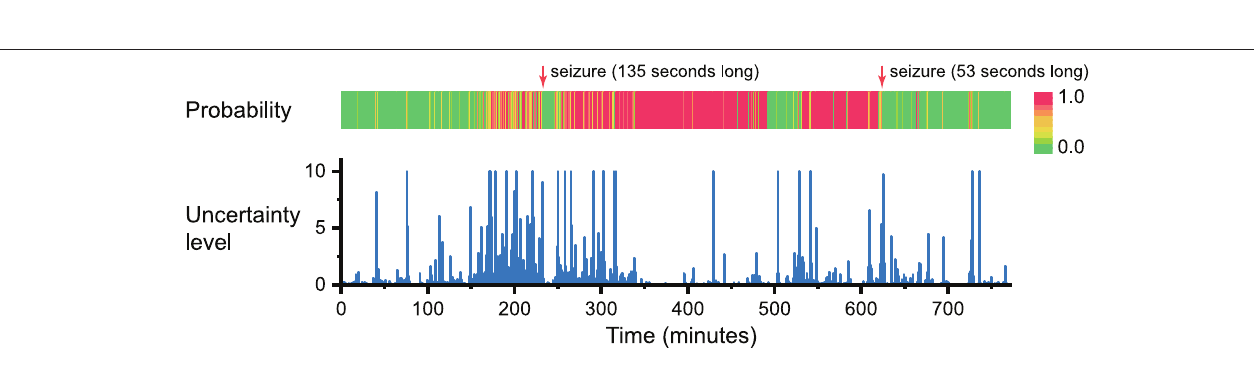
FIGURE 6 | Prediction score and uncertainty level produced by Bayesian convolution neural network in seizure forecasting task over 13 h of continuous EEG recording. For the sake of visualization, for all uncertainty levels higher than 10, we set them to 10.